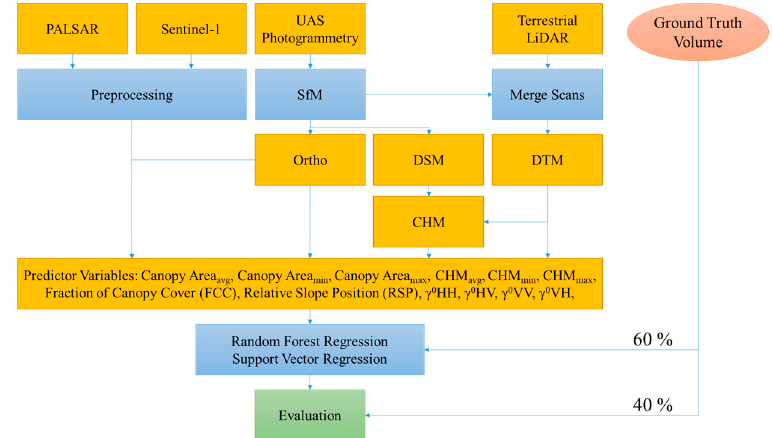
Figure 2. Flowchart of the methodology. Terrestrial laser scanning (TLS) was used for ground truthing and generation of the digital terrain model (DTM). A UAS was utilized for collecting aerial images, which were then processed to obtain a digital surface model (DSM) and orthoimages. Phased Array type L-band Synthetic Aperture Radar-2 (PALSAR-2) and Sentinel-1 data were preprocessed and used as independent variables. All variables were incorporated in the end with different regression analysis for the test.